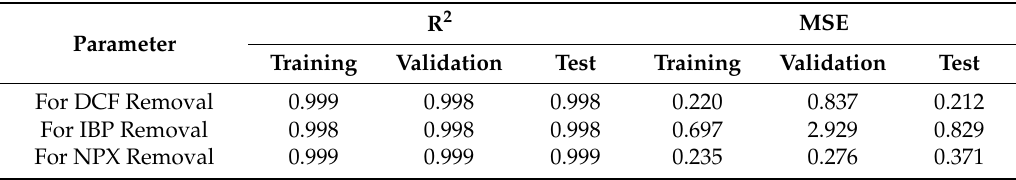
Table 3. R 2 and MSE values for the removal of each pollutant in the selection of the best model. R Parameter